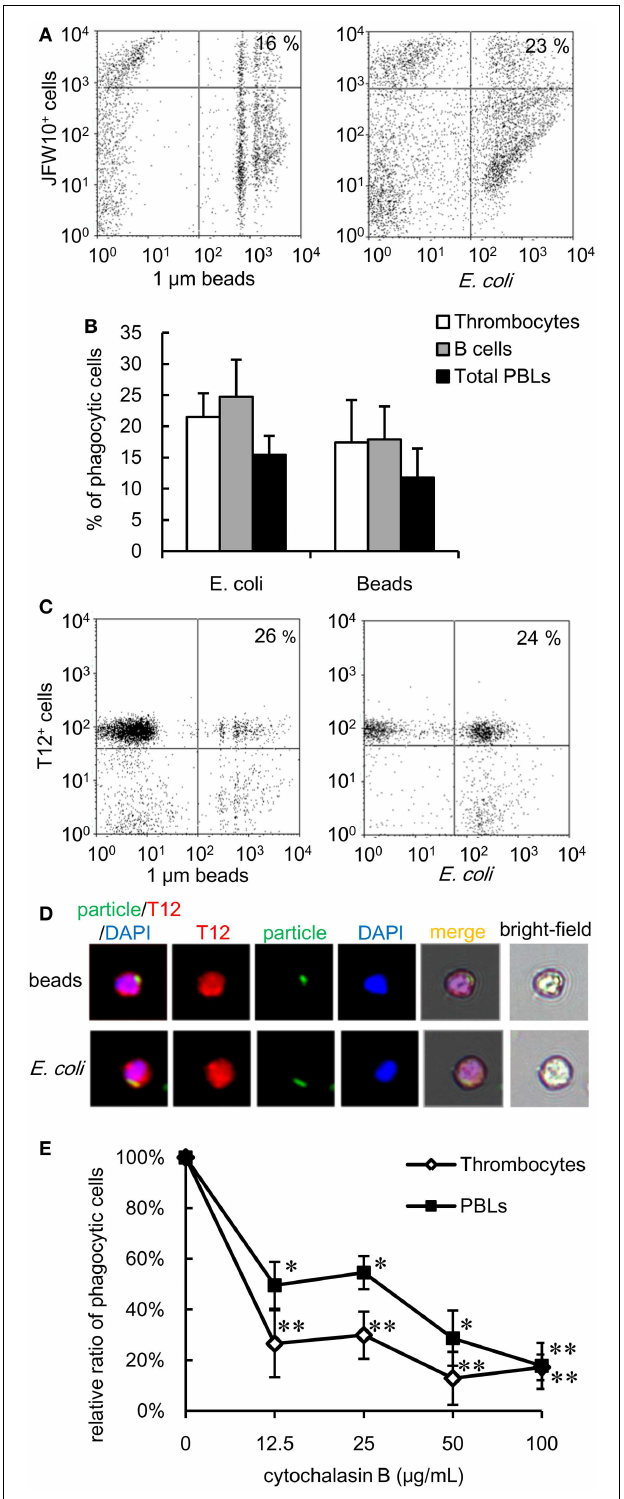
FIGURE 7 | Phagocytic thrombocytes in other vertebrates are shown . (A,B) Phagocytosis by flounder thrombocytes and B cells. (A) Flow cytometry of flounder thrombocytes incubated with fluorescent latex beads